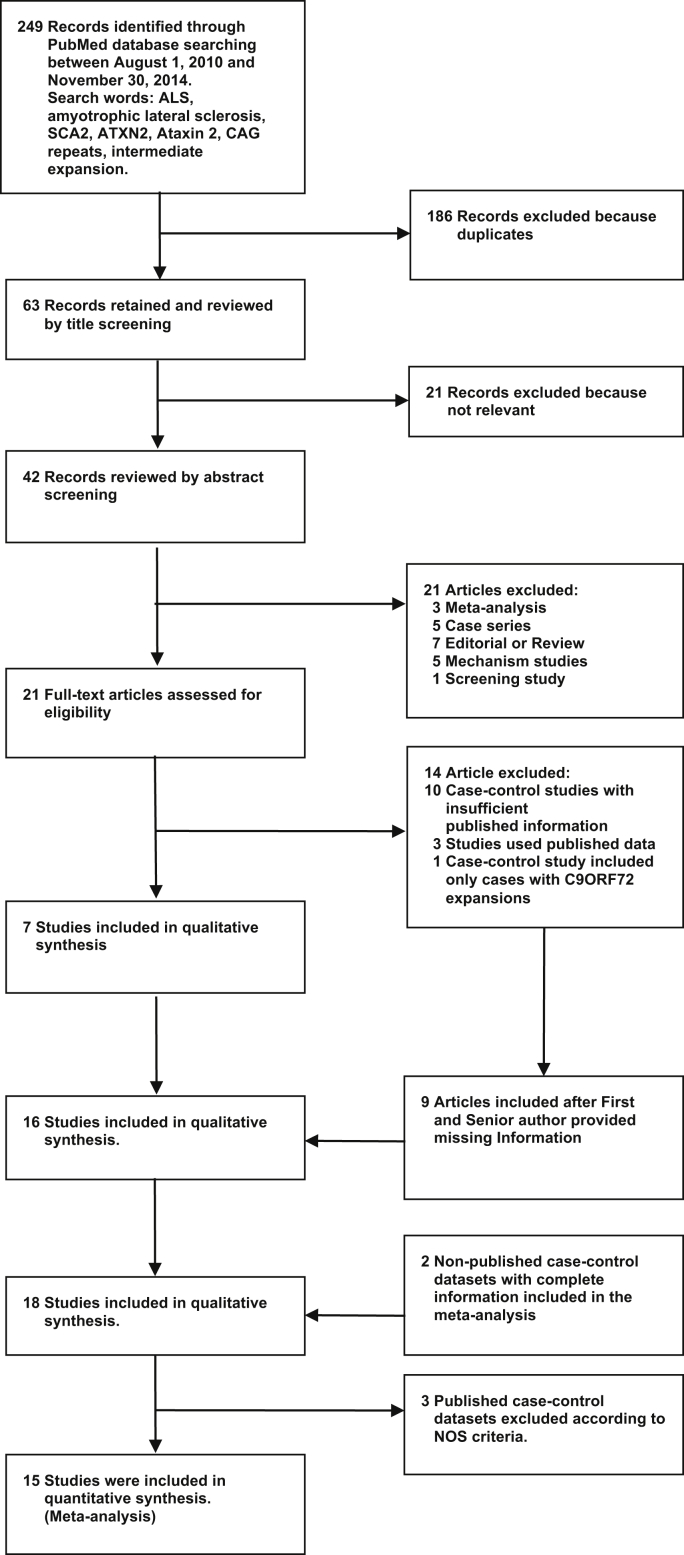
Flow chart of study selection according to the PRISMA protocol. Thirteen previously published studies were selected for analysis, 7 from Europe (Conforti et al., 2012, Corrado et al., 2011, Daoud et al., 2011, Gispert et al., 2012, Lattante et al., 2014, Van Damme et al., 2011, Van Langenhove et al., 2012), 3 studies of Han Chinese (2 from China [Liu et al., 2013, Lu et al., 2015] and 1 from Taiwan [Soong et al., 2014]), 1 from Turkey (Lahut et al., 2012), and 2 studies from the USA (Elden et al., 2010, Ross et al., 2011).